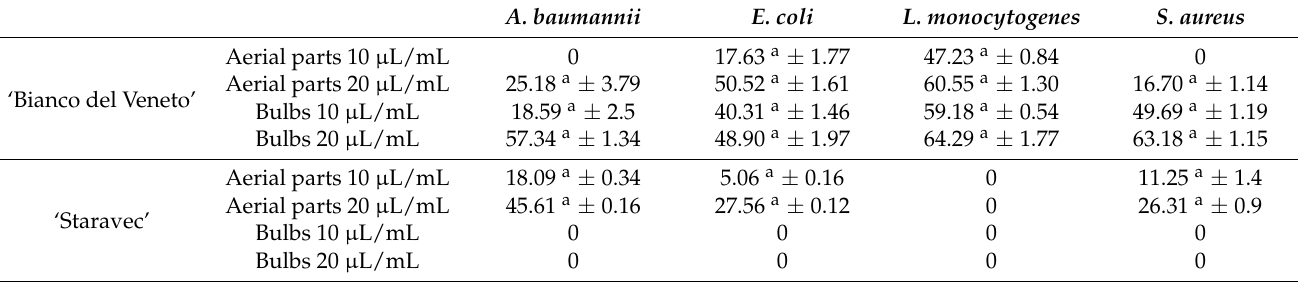
Table 3. Inhibitory activity of the EOs from the A. sativum cultivars on the biofilm formation capacity by the pathogenic bacterial strains Acinetobacter baumannii , Escherichia coli , Listeria monocytogenes , Staphylococcus aureus